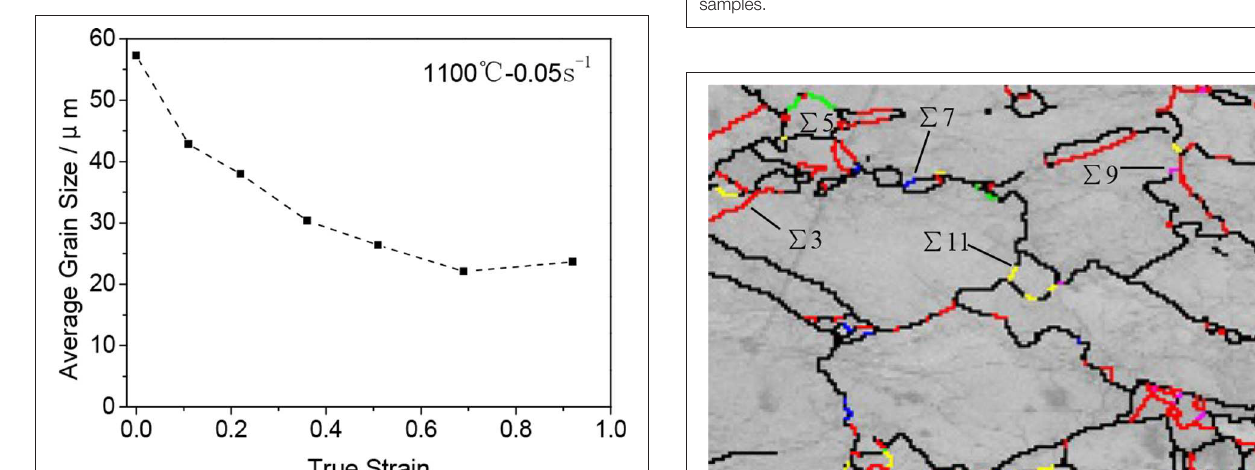
FIGURE 9 | The misorientation distribution of annealed sample and deformed samples.